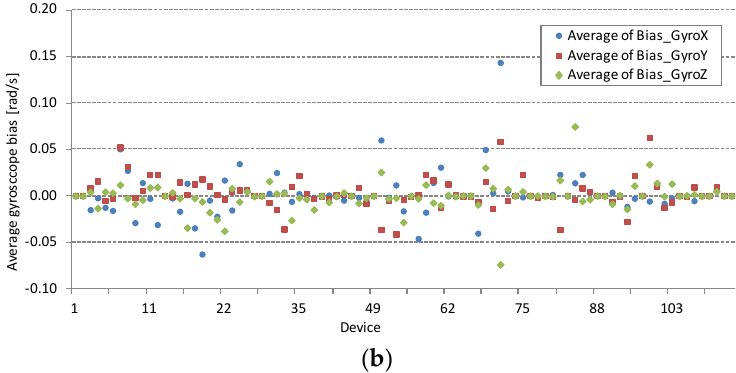
Figure 2. Accelerometer and gyroscope bias measurements of X , Y and Z axes. ( a ) Average accelerometer biases of 116 different smartphones are plotted; ( b ) Average gyroscope biases of smartphones with gyroscopes are plotted. The horizontal axis represents the device identification number (ID) from the measurement database.